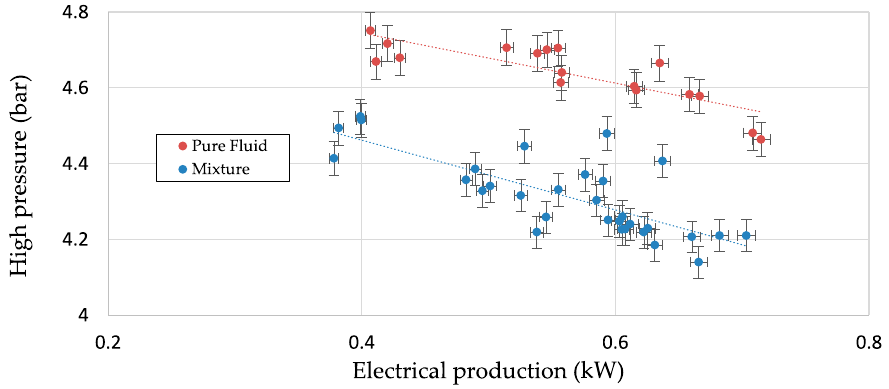
Figure 11. ORC performances according to the electrical production in the pure fluid and the 429